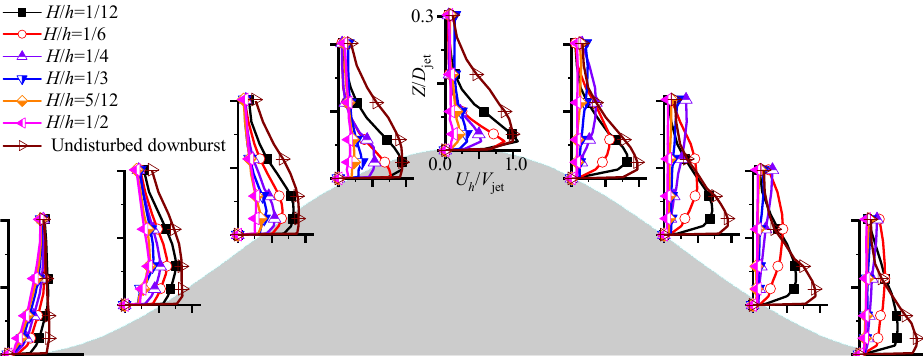
Figure 7. Profiles of horizontal wind velocity on x -axis ridge ( L = 0.5 D jet , r h = 1.0 D jet